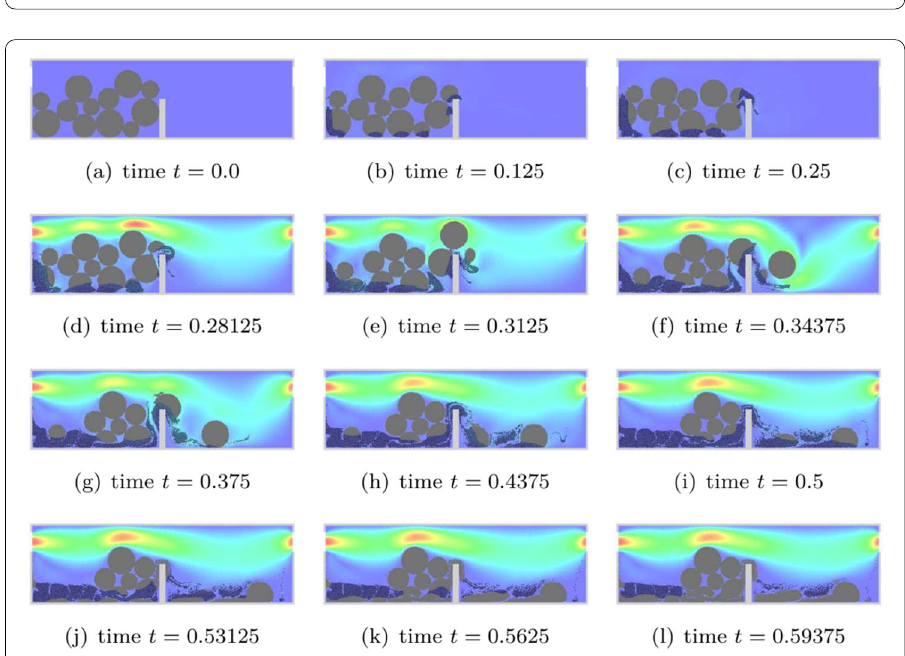
Fig. 13 Powder grains exposed to a highly dynamic gas flow: time series of the obtained results with magnitude of the velocity field ranging from 0 . 0 (blue) to 600 . 0